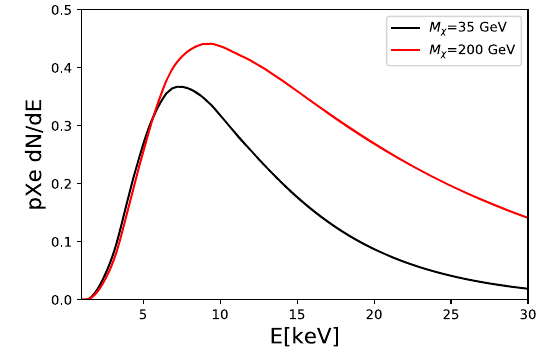
6 , 10 , 20 , 40 , 100 , 200 GeV respectively. Right: recoil energy distribu- tions convoluted with the XENON1T acceptance p Xe ( E ) for M χ = 35 ( 200 ) GeV and σ 90 = 4 . 71 ( 17 . 1 ) × 10 − 47 cm